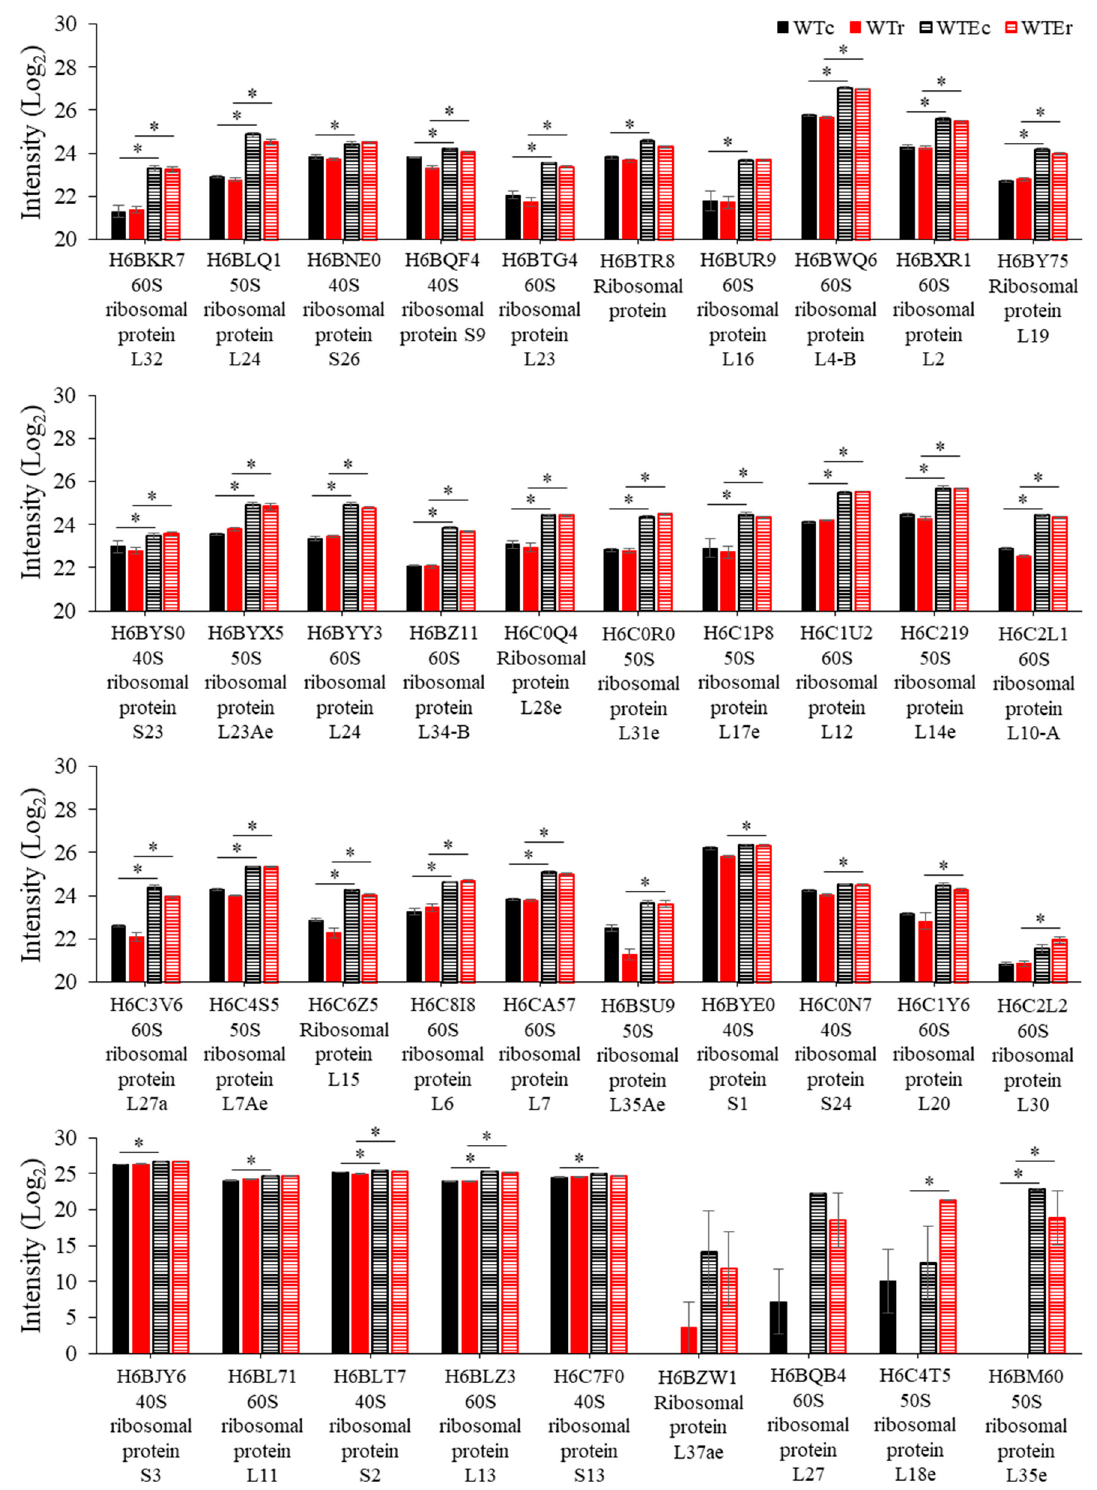
Figure 5. Intensity levels of non-ribosomal proteins increased in the Evolved strains, in comparison with WT strains. Note that only a portion of the Y axis is shown in the upper panel to highlight the small, but significant, differences in intensity levels. Error bars represent standard error. Asterisks indicate instances of statistically significant comparisons.